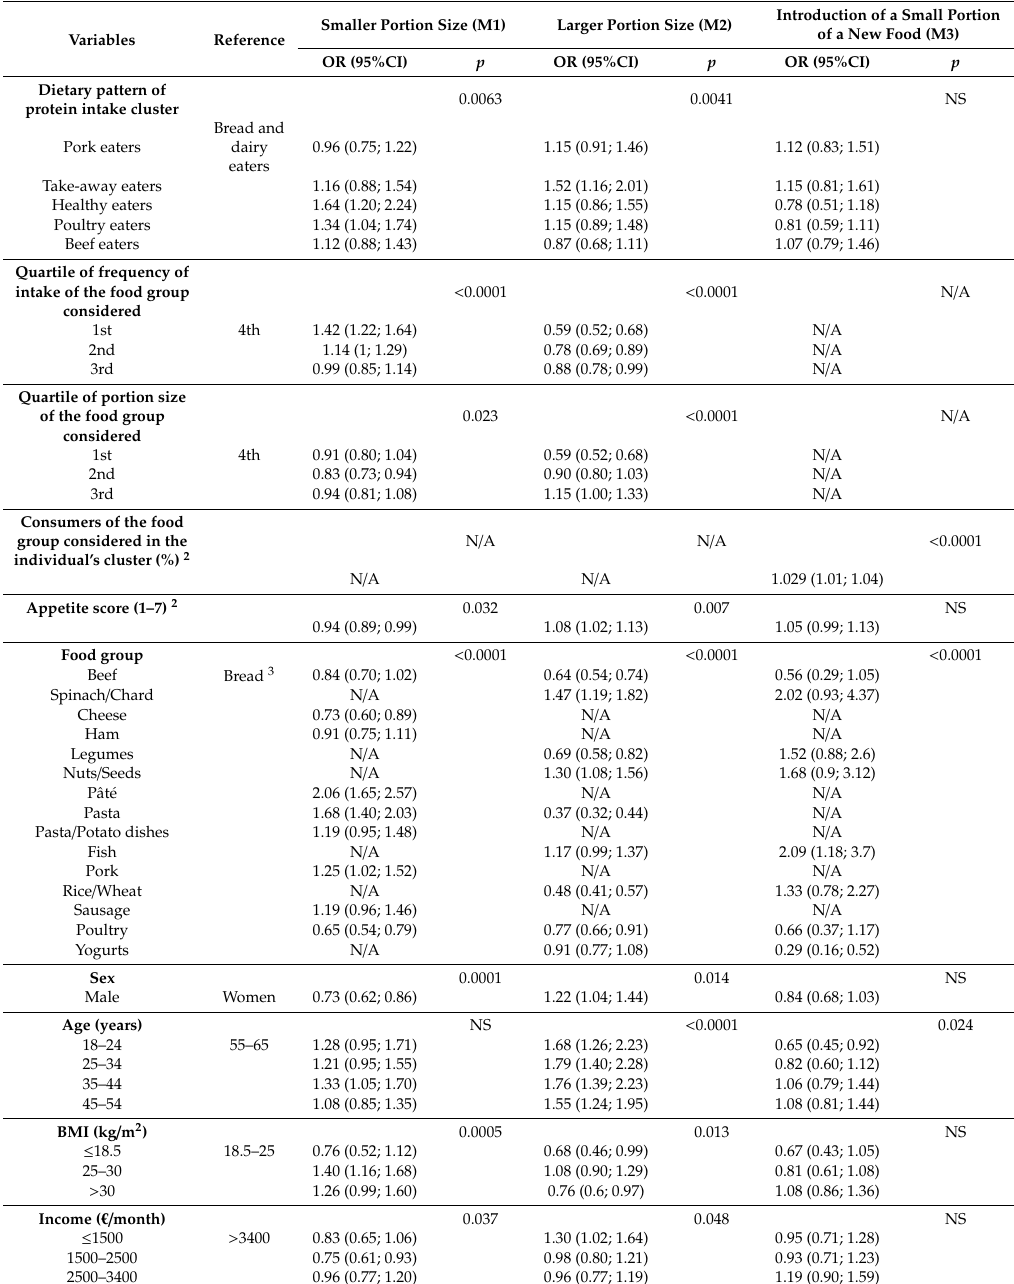
Table 1. Associations between willingness to change and the dietary and socio-demographic characteristics of the individuals assessed using the general linear mixed model of binomial logistic regressions 1